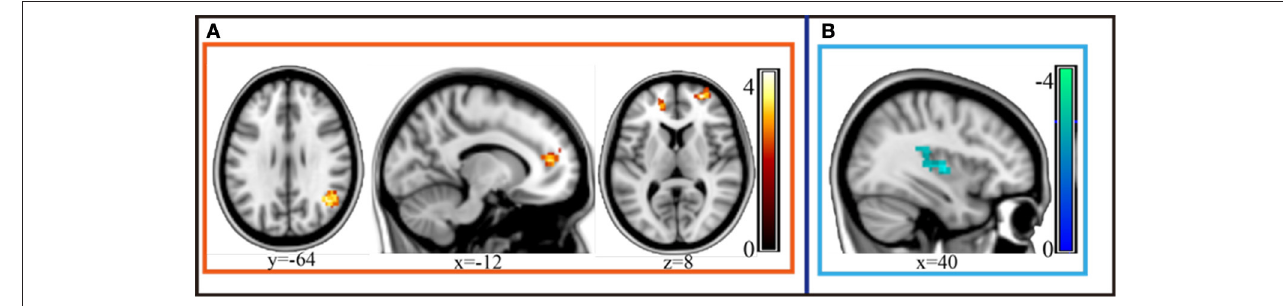
FIGURE 2 | gFCD of the depressive group statistically increased in the perigenual anterior cingulate cortex (pgACC), orbitofrontal cortex bilaterally and the left-supramarginal gyrus after MECT ( p < 0.05, FEW). (A) Statistical increased gFCD in these regions post treatment. (B) Statistical decreased gFCD in these regions post treatment.